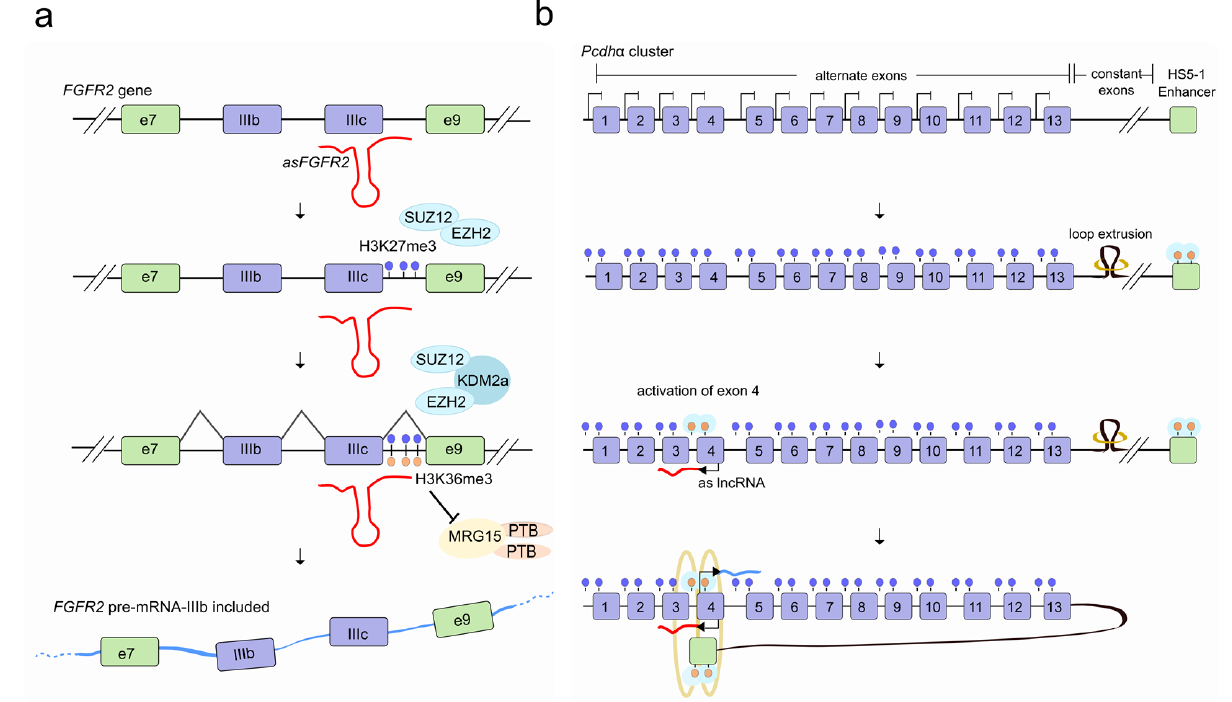
Figure 2. LncRNAs regulate alternative splicing through chromatin modification. ( a ) In epithelial cells, the antisense lncRNA asFGFR2 (red), recruits the Polycomb-group proteins EZH2 and SUZ12 to the FGFR2 gene locus and allows H3K27me3 deposition (blue lollipop) and a decrease in methylation of H3K36me3 (orange lollipop) by the recruitment of the H3K36 demethylase KDM2a. As a result, the chromatin-splicing adaptor complex MRG15–PTB1 can no longer bind to exon IIIb, which is then included in the FGFR2 transcript (light blue). ( b ) The activation of a specific antisense lncRNA (as lncRNA; red) at the Pcdh α promoter of one (out of 13) alternate first exon promotes proximal DNA demethylation (orange lollipop) and CTCF (turquoise) recruitment and favors the interaction between the selected promoter and a distant HS5-1 enhancer by a long-range DNA loop. This ultimately triggers sense transcription (light blue) of the corresponding selected Pcdh α first-exon which is individually spliced to a downstream constant region to form a distinct transcript.